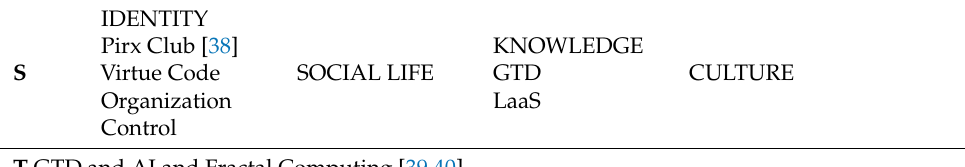
Table 2. Illustrating the ReSeT model in the context of the wellness domain.